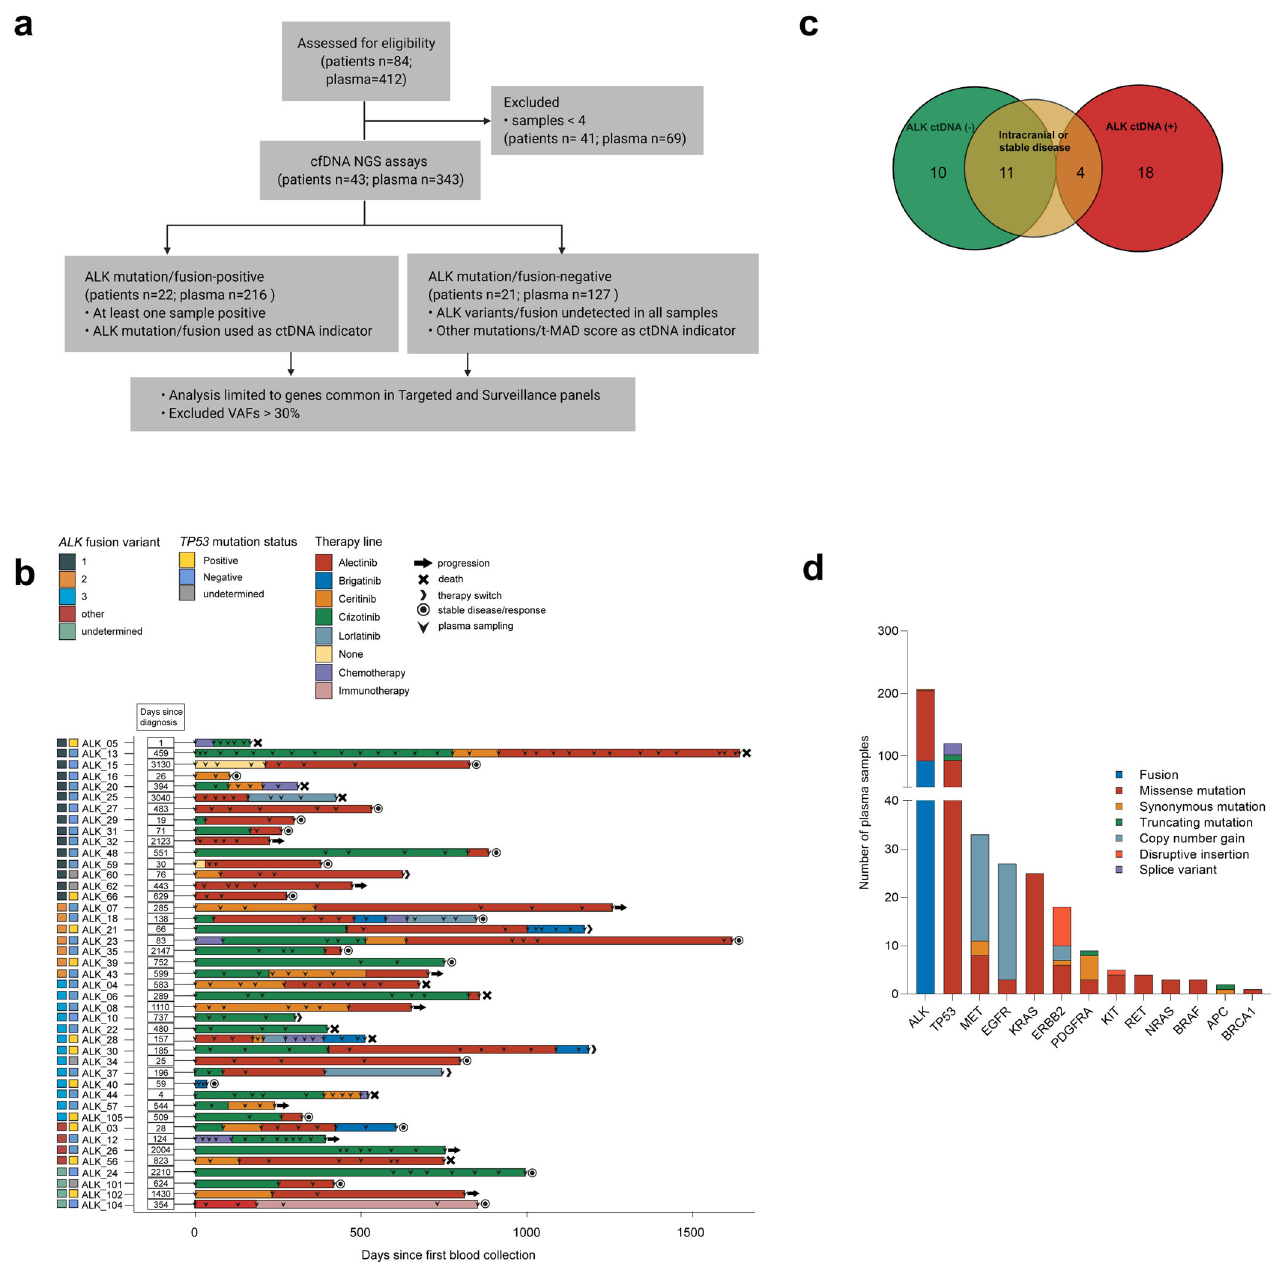
Fig. 1 Overview of the ALK + NSCLC cohort. a Untargeted sWGS and targeted NGS assays were used to assess ctDNA in 43 ALK + NSCLC patients corresponding to 343 longitudinal plasma samples. Targeted NGS analysis only included genes common to both the Avenio Targeted and Surveillance panels. In total, 51% (22 of 43) of patients had an ALK alteration in at least one liquid biopsy. b Timeline of plasma collection and therapy administration in the patient cohort. ALK fusion variants and TP53 status from tissue analysis at diagnosis are indicated by colored boxes. c Distribution of patients based on detected ALK alterations — including mutations and rearrangements. The group without detectable ALK alterations (ALK − ) is enriched for patients with intracranial progression or stable disease. d Molecular alterations identi fi ed in 174 ctDNA ( + ) plasma samples based on